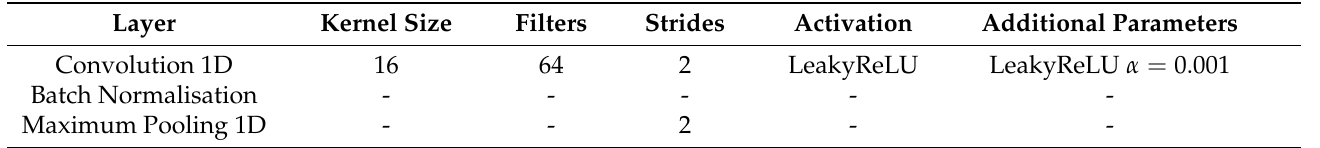
Table A2. The layer details of Block 2.0.